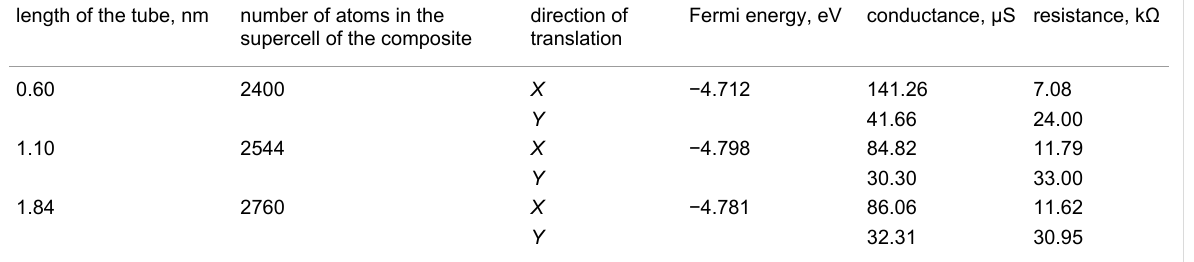
Table 2: Data of investigated two-layer composite films and the results of modeling. length of the tube,